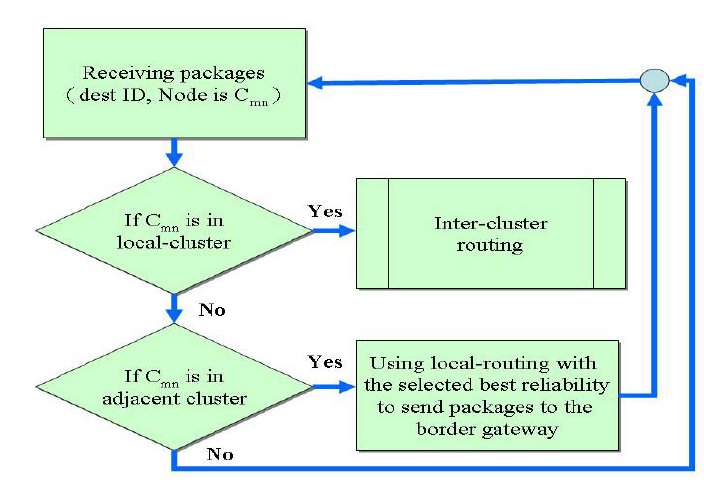
Figure 11. Inter-cluster routing